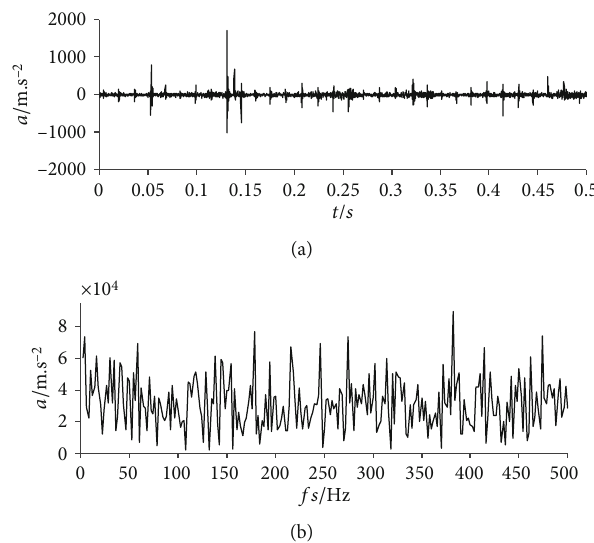
Figure 7: Waveform and frequency spectrum of bearing R outer ring defect. (a) Waveform. (b) Frequency